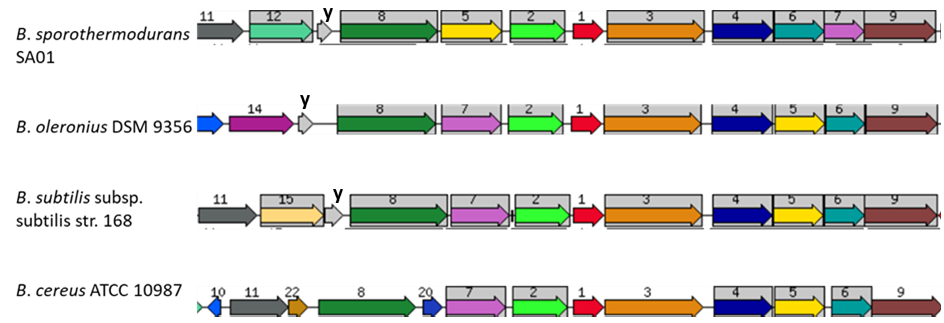
Figure 7. Comparison of chromosomal regions of the heat shock protein GrpE (1; red) of B . sporothermodurans SA01, B . oleronius DSM 9356, B . subtilis subsp. subtilis str. 168, and B . cereus ATCC 10987. Sets of genes with similar sequences are grouped with the same number and color. Genes whose relative positions are conserved in at least four other species are functionally coupled and share grey background boxes. Proteins of interest in the region are as follows: 2, heat-inducible transcription repressor HrcA; 3, chaperon protein DnaK; 4, chaperon protein DnaJ; 5, hypothetical radical SAM family enzyme in heat shock genes cluster; 6, ribosomal protein L11 methyltransferase; 7, ribosomal RNA small subunit methyltransferase; 8, translation elongation factor LepA; 9, tRNA-t(6)A37 methylthiotransferase; 10, endopeptidase spore protease Gpr; 11, SSU ribosomal protein S20p; 12, stage II sporulation protein P (SpoIIP); 14, sodium-dependent phosphate transporter; 15, transamidase GatB domain protein; 20, transcriptional regulator, HxIR family; 22, hypothetical protein; y , yqe P/ yqx A gene.